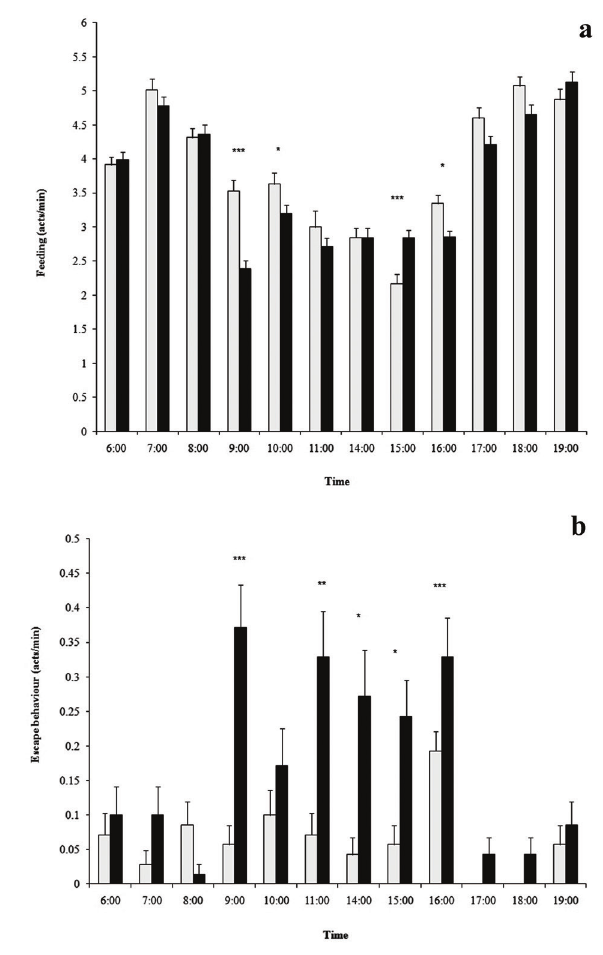
Fig. 7. Variation of behaviour patterns between No Tourism and Tourism site for M. bonita (mean and SEM); (a) Feeding; (b) Escape. Lighter bars = No Tourism; darker bars = Tour- ism. (Mann -Whitney U-test). N= 70; *p < 0.05; **p < 0.01; ***p < 0.0001.